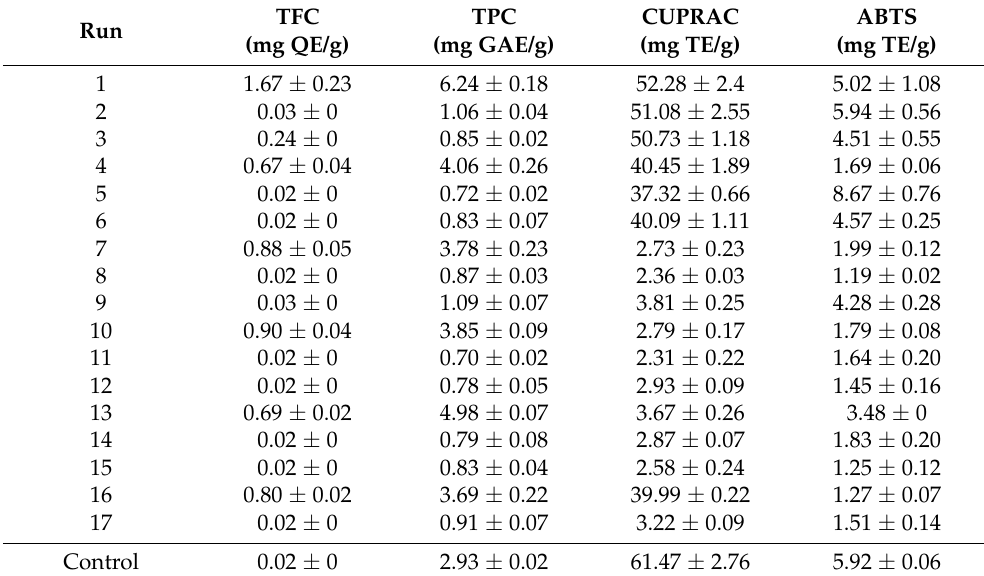
Table 8. Total flavonoid content (TFC), total phenolic content (TPC), and antioxidant activity (CUPRAC and ABTS) of bee pollen